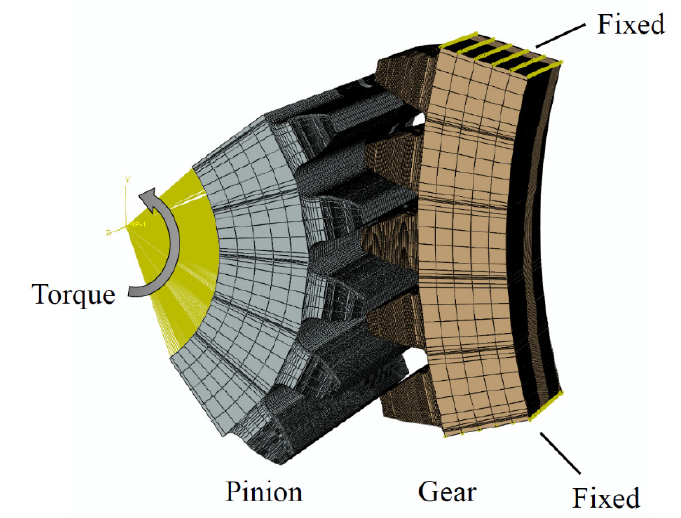
Figure 4. Boundary condition of finite element analysis.